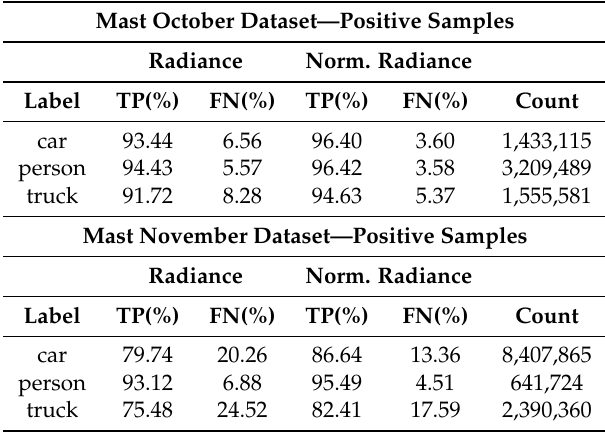
Table 4. Classification results of automatically annotated data. TP = True Positive, FN = False Negative. Mast October Dataset—Positive Samples